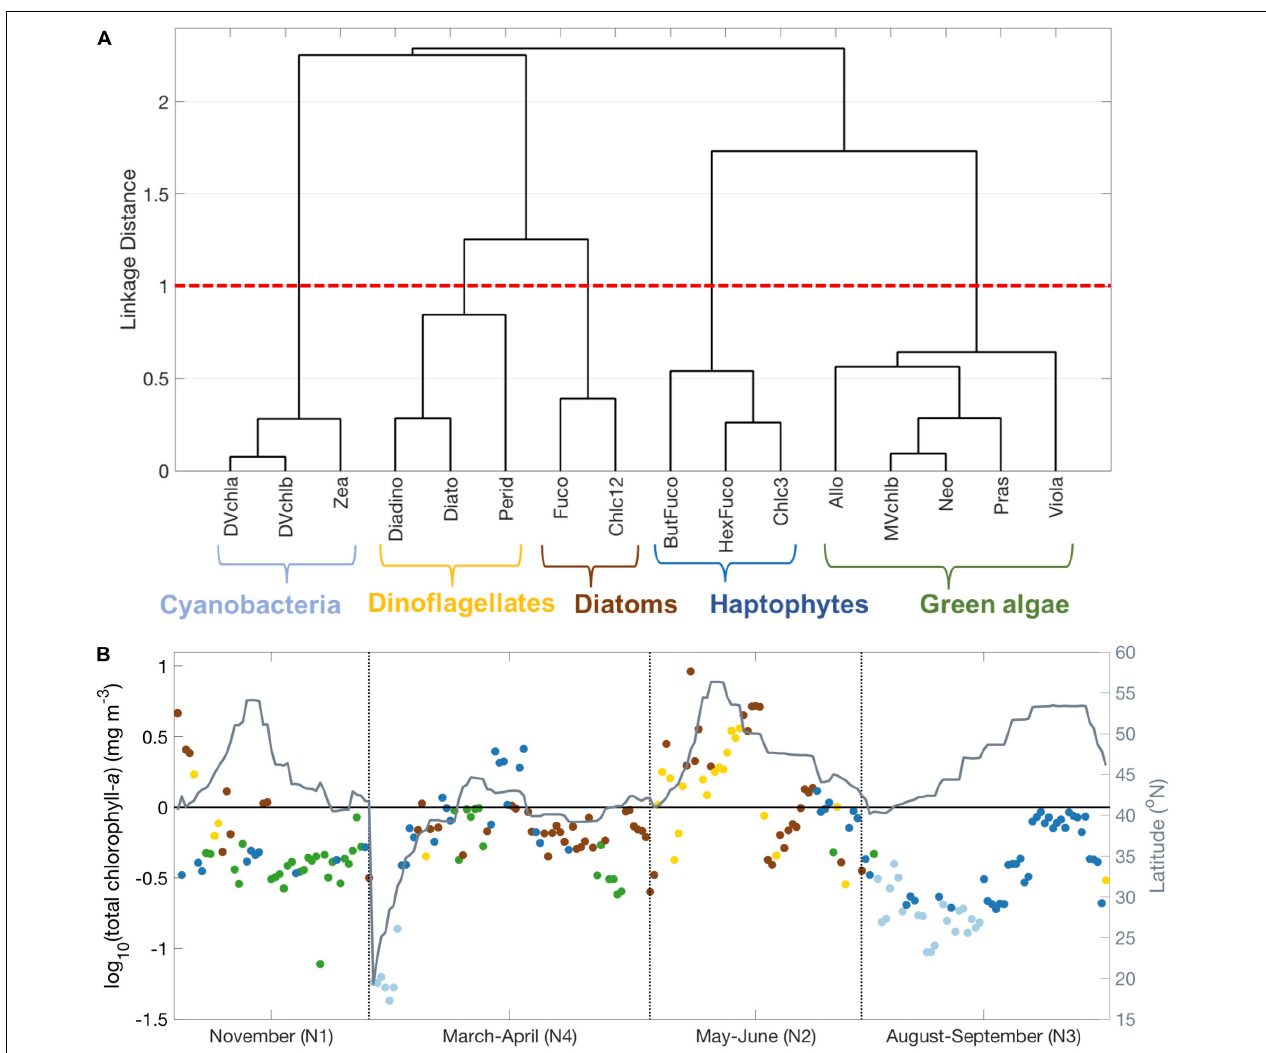
FIGURE 3 | Hierarchical clustering of phytoplankton pigment ratios to total chlorophyll- a concentration. (A) Dendrogram showing five major phytoplankton pigment groups delineated with brackets, defined by a linkage distance cutoff of 1 (dashed red line). (B) Spatiotemporal distribution of surface samples on NAAMES colored by the cluster to which that sample was assigned (light blue = cyanobacteria, dark blue = haptophytes, green = green algae/mixed, brown = diatoms, gold =